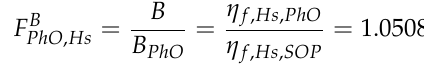
Figure 6. Cascade of losses for boiler.